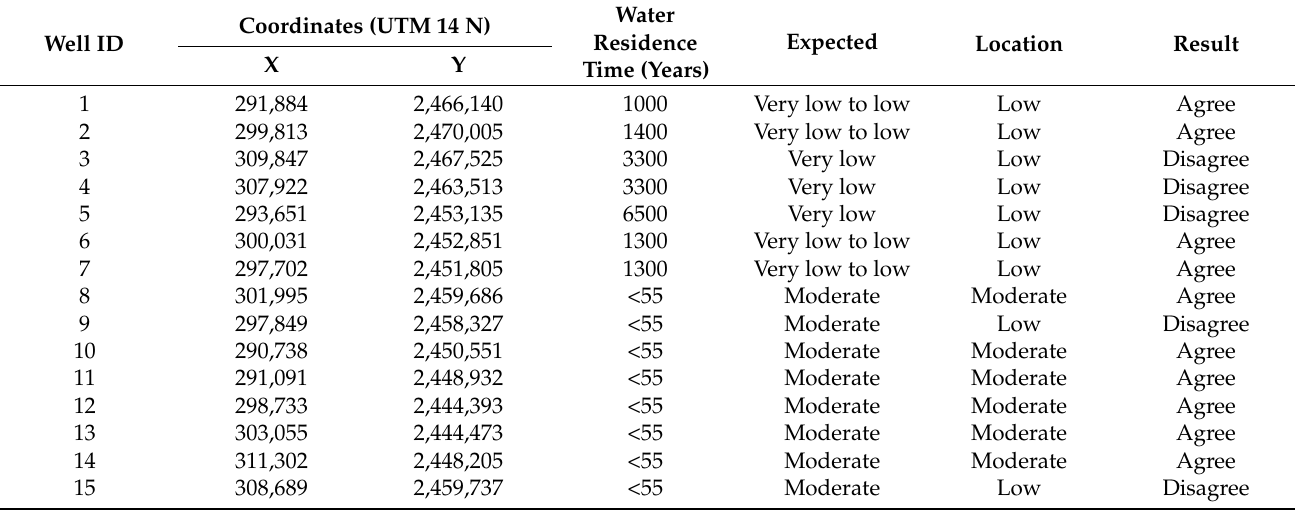
Table 8. Water residence age of wells and their groundwater